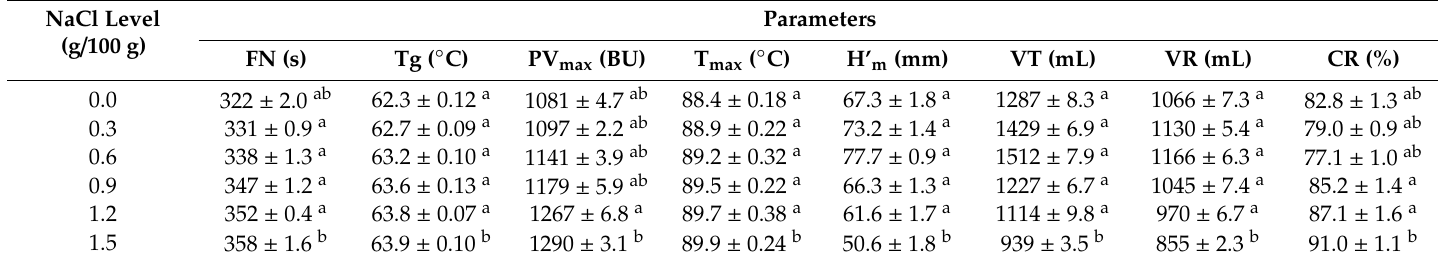
Table 5. E ff ects of di ff erent levels of sodium chloride addition on dough rheological properties during fermentation, gelatinization properties, and α -amylase